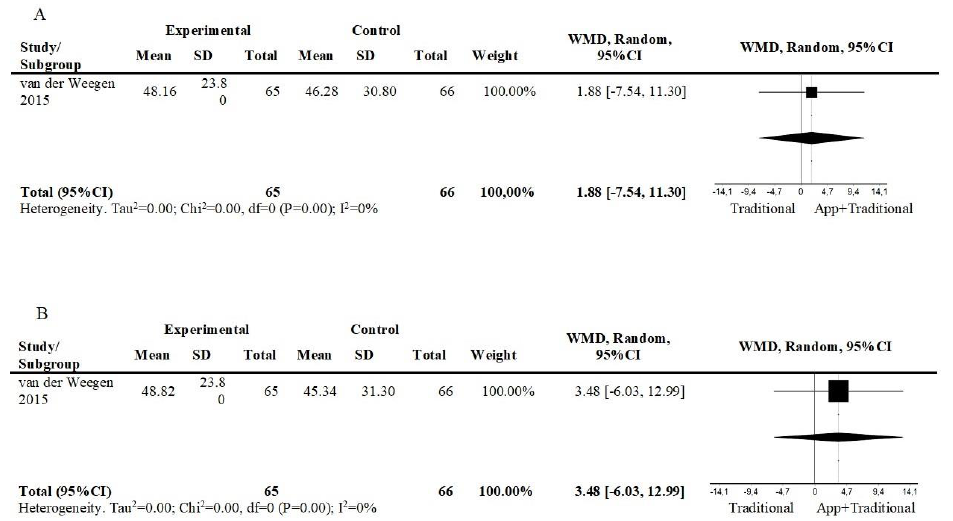
Figure 4. Forest plot of comparison, outcome: minutes in moderate to vigorous physical activity: A) App+Traditional vs. Traditional, short term; B) App+Traditional vs. Traditional, follow-up. Abbreviations: CI, confidence interval; df, degrees of freedom; WMD, weighted mean difference.